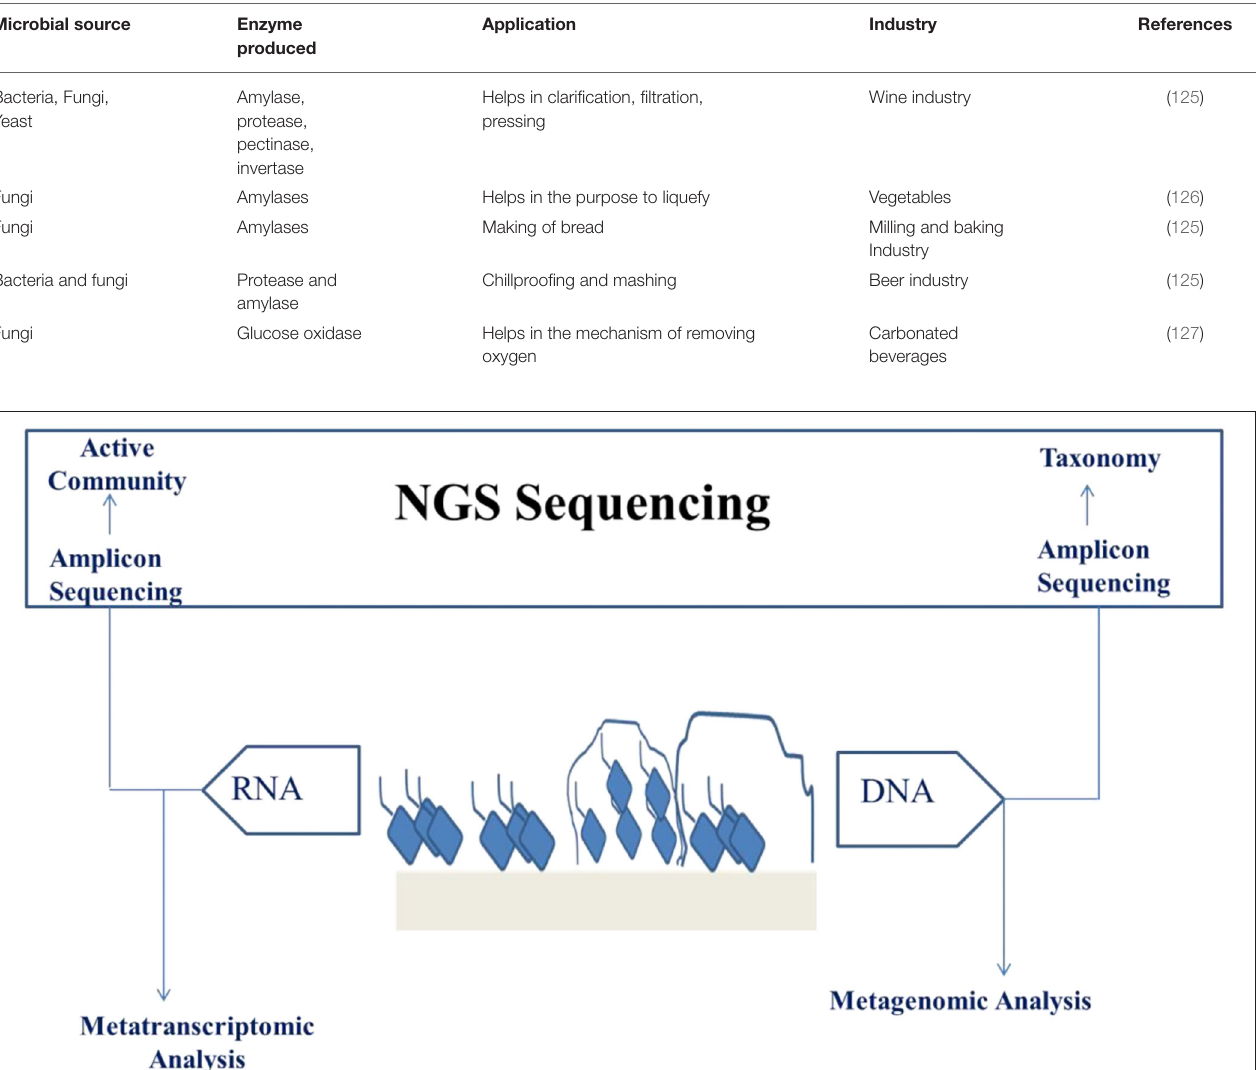
Frontiers in Nutrition |